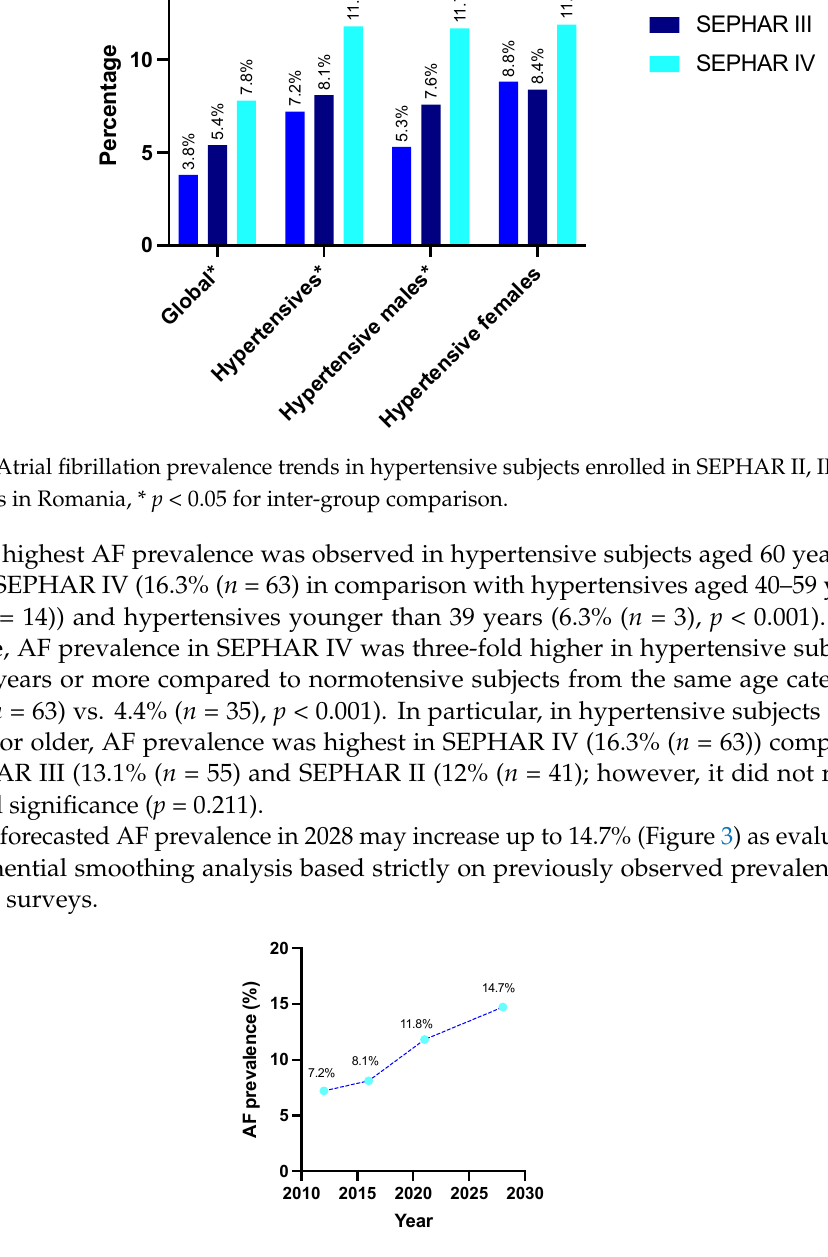
Figure 2. Atrial fibrillation prevalence trends in hypertensive subjects enrolled in SEPHAR II, III and IV surveys in Romania, * p < 0.05 for inter ‐ group comparison.